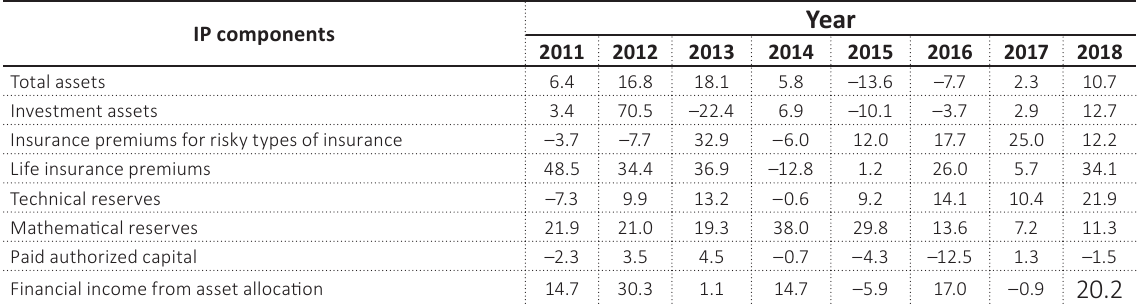
Table 1. Annual growth rates of IC in Ukraine in 2011–2018, % Source: Calculated by National Commission for State Regulation of Financial Services Markets